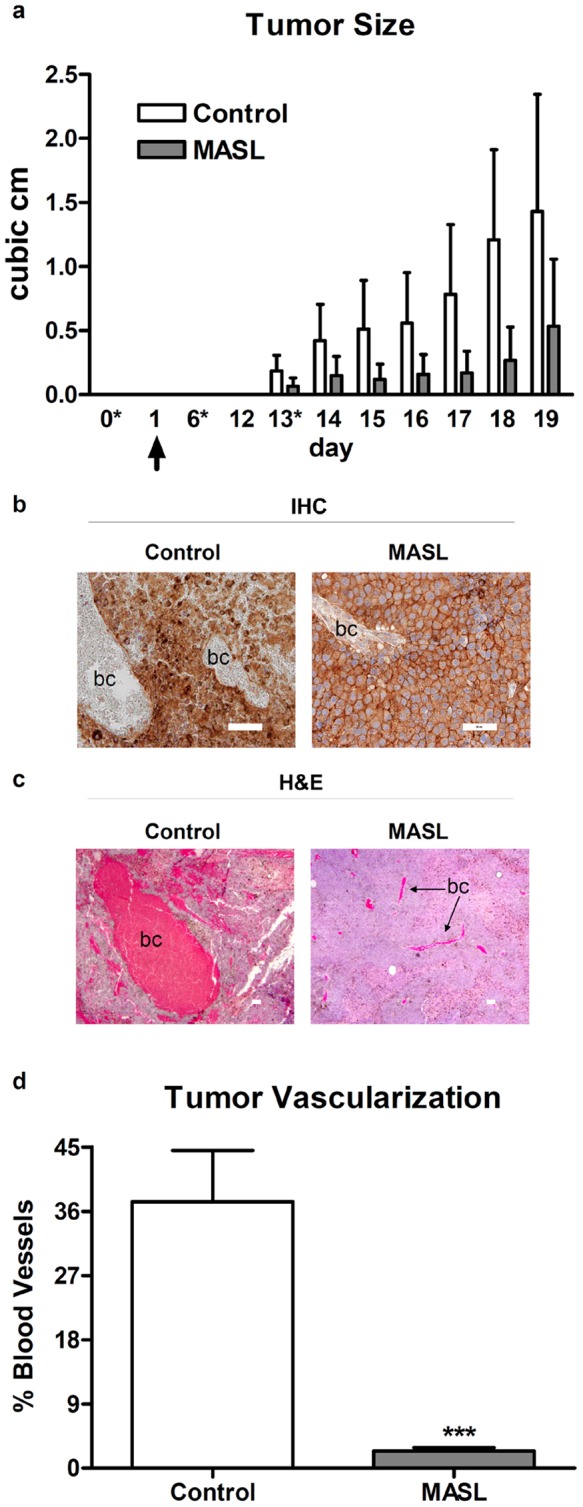
Dietary MASL inhibits melanoma growth in vivo.(a) Mice were fed MASL to achieve a dosage of 0 or 25 mg/kg once weekly (indicated by asterisks) and inoculated subcutaneously with B16 melanoma cells (100,000 cells per mouse on day indicated by arrow). Tumors were measured daily by caliper, and data is shown as cubic cm (mean + SEM, n = 4). (b) Tumors were evaluated for PDPN expression by IHC as indicated (bar  = 50 microns). “bc” indicates blood filled vascular spaces lined by tumor cells. (c) Tumors were examined by hematoxylin and eosin staining (H&E) to visualize vascularization and morphology. (c) Tumor vascularization was quantified as the percent of each field (0.8 mm2) occupied by blood vessels and shown as mean + SEM (n = 7).